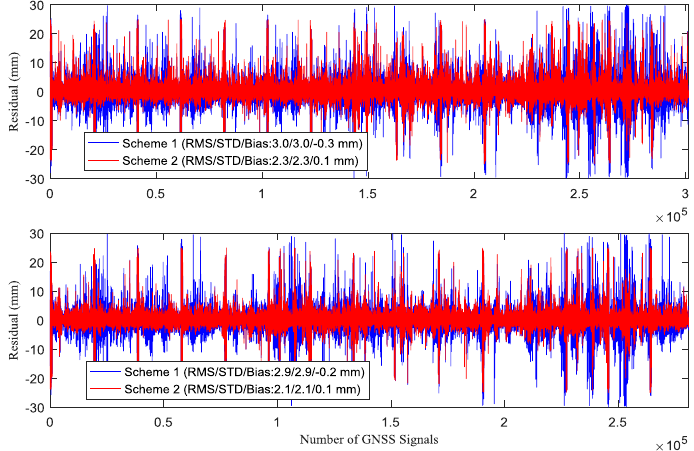
Figure 4. Residuals of the slant wet delay using two schemes with 10° (top) and 15° (bottom) elevation angle mask over the experimental period of Doy 303 to 317, 2015.